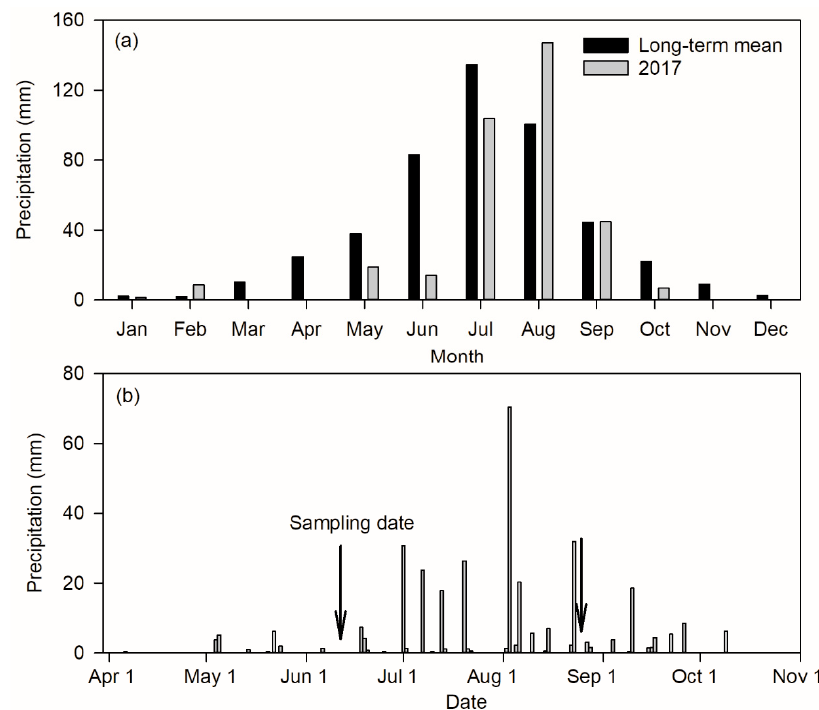
Figure 1. Long-term monthly mean precipitation and monthly precipitation in 2017 ( a ), and daily precipitation ( b ) in the growing season of 2017. Arrows indicate sampling dates.